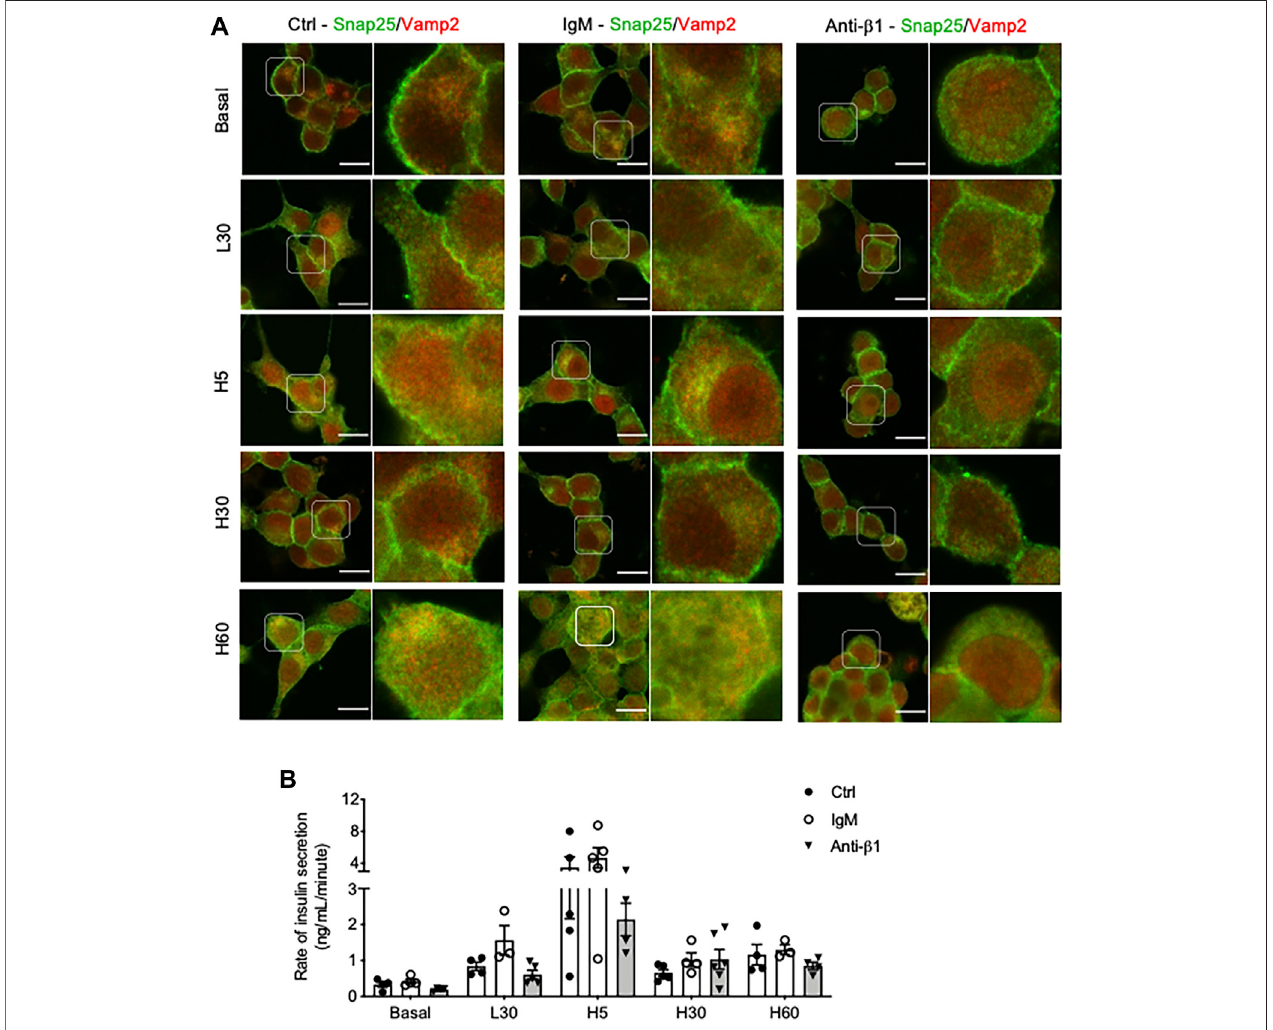
FIGURE 8 | Blocking β 1-integrin diminishes INS-1 cell Snap25/Vamp2 colocalization during GSIS and rate of insulin secretion throughout GSIS. Representative double immunostaining of (A) Snap25(green) and Vamp2 (red) in INS-1 cells cultured on collagen IV and treated with anti- β 1, IgM, or untreated control (Ctrl) for 24hrs following one of fi ve conditions: no treatment (basal) low glucose (2.2 mmol) for 30 min (L30), high glucose (22 mmol) for 5 min (H5), 30 min (H30), and 60 min (H60). Nuclei are counterstained with DAPI, and magni fi ed images are highlighted. Scale bar: 10 µm. (B) Rate of insulin secretion (ng/mL/minute) in each of the treatment groups. Data are expressed as mean ± SEM ( n = 3 – 5